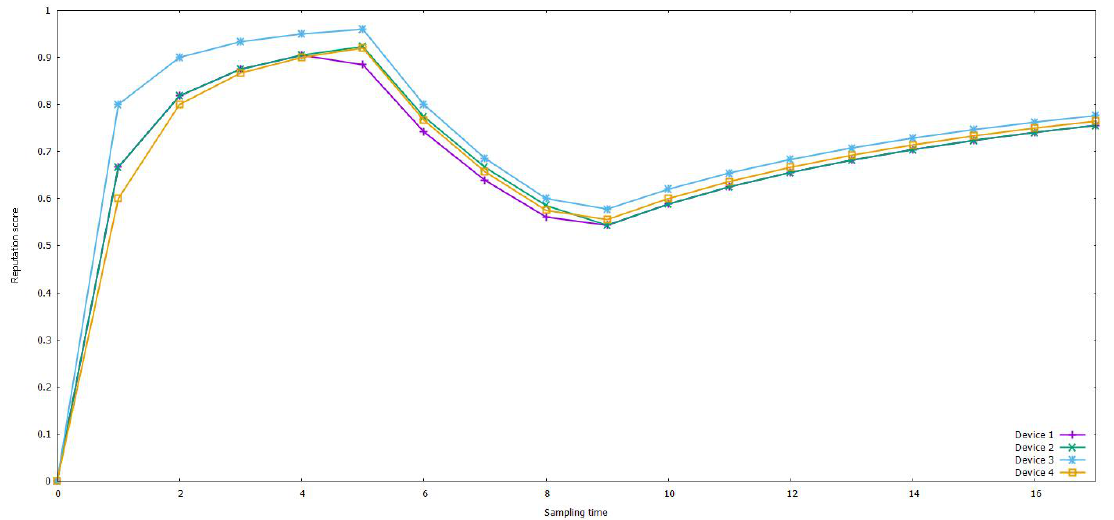
Figure 9. System reputation of each device, obtained in test